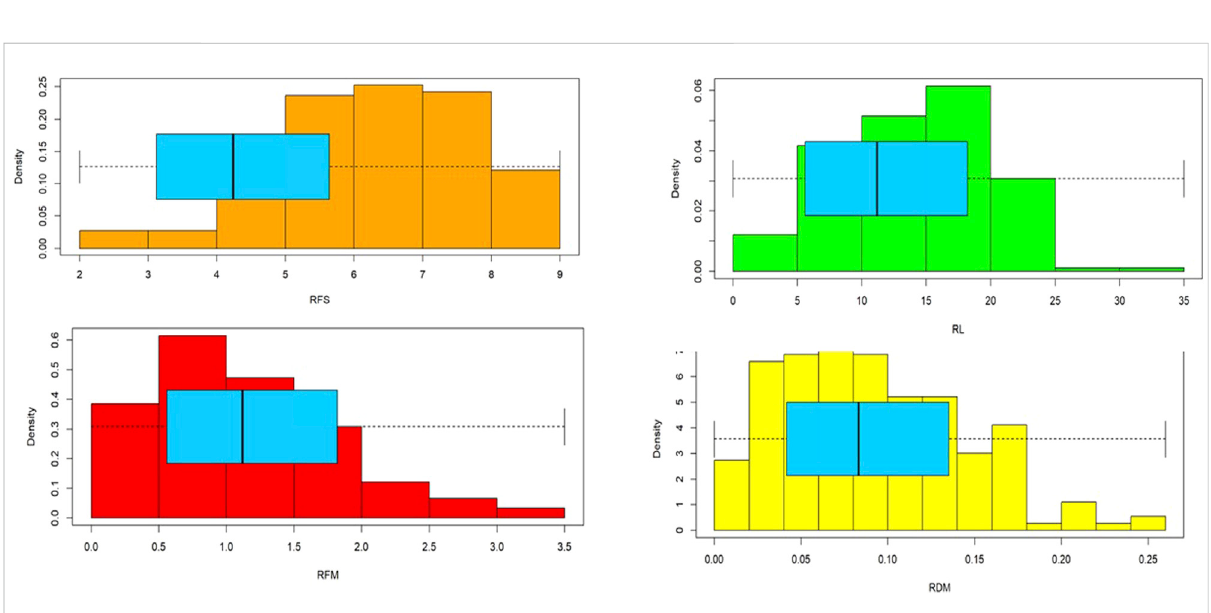
1.94 – 30.88 cm for RL, 0.11 – 3.44 g for RFM, and 0.01 – 0.26 g